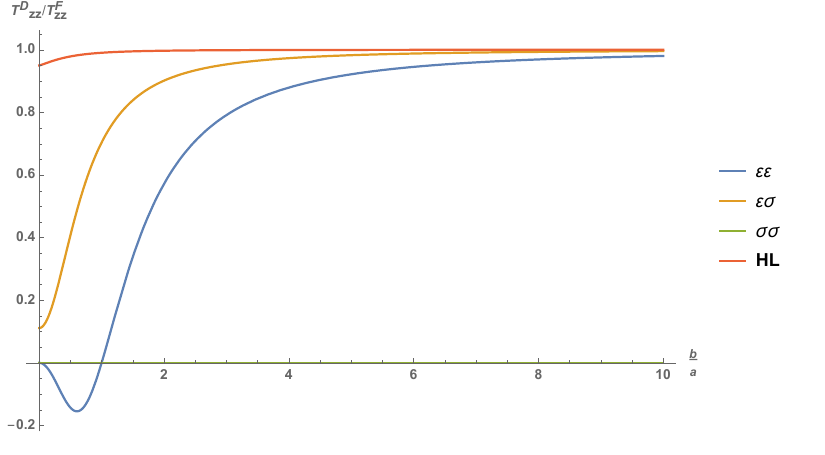
L = 2 and (cid:11) = 0 : 7.